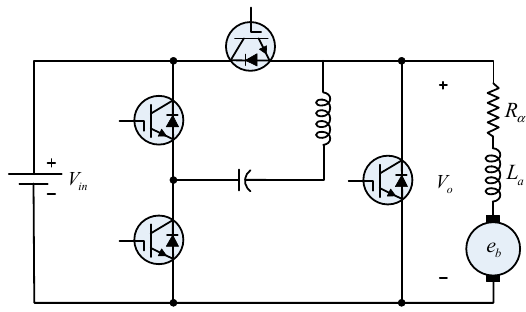
Figure 15. Zero-current-transition converter fed DC motor drive .